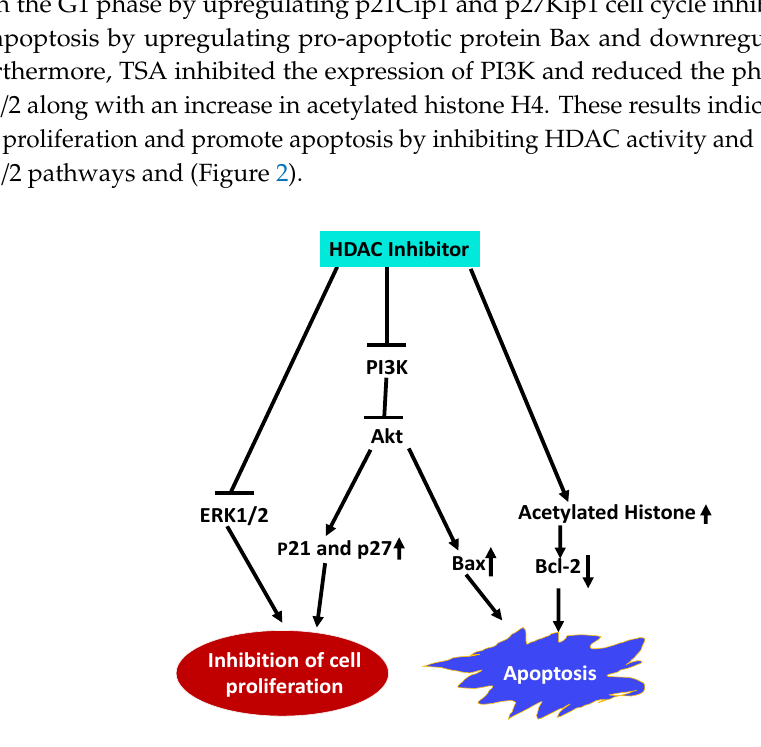
Figure 2. Schematic representation of HDACI Trichostatin A (TSA) effects on Esophageal squamous cell carcinoma (ESCC). TSA inhibits ESCC proliferation, and arrests cells in G1 phase by upregulating by p21Cip1 and p27Kip1. It inhibits cell proliferation by inhibiting PI3K expression, and reducing activation of Akt and ERK1/2. Promotes apoptosis by altering expression of pro- and anti-apoptotic proteins, and increases histone acetylation [146]. (Blunt end lines indicate inhibition, upward arrows indicate upregulation and downward arrows indicate downregulation of proteins).